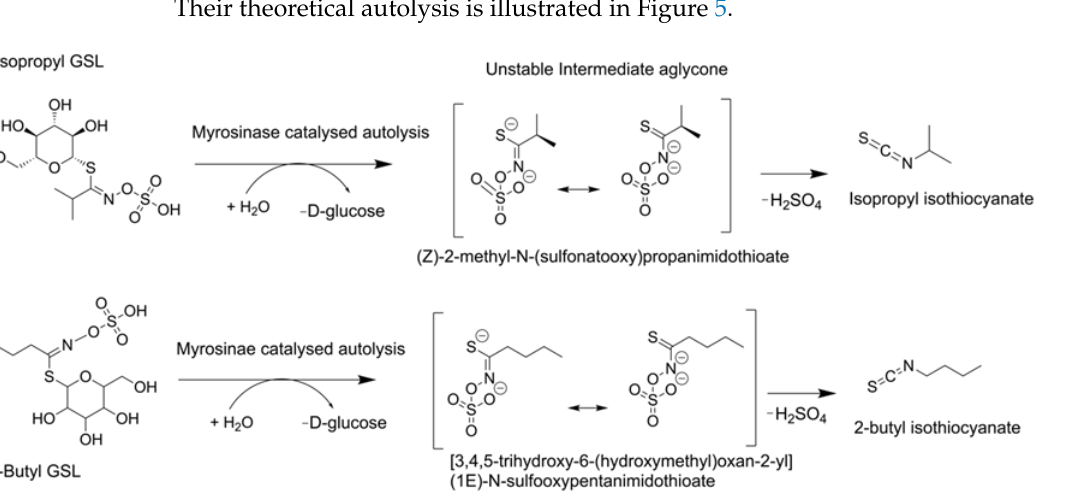
Figure 5. Schematic reaction mechanism showing GSL autolysis, intermediate unstable aglycone and final products.